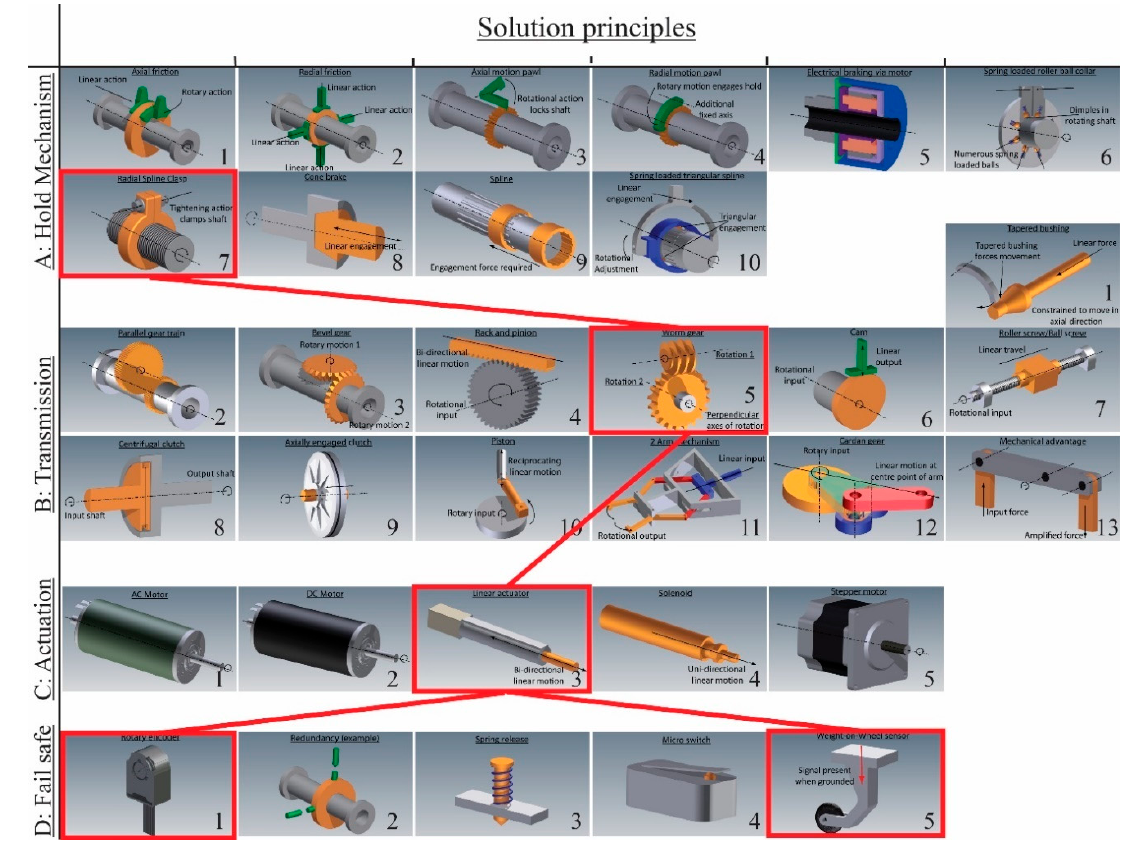
Figure A1. Morphological chart used during concept selection. (boxes indicates solution principles composing the winning concept solution).